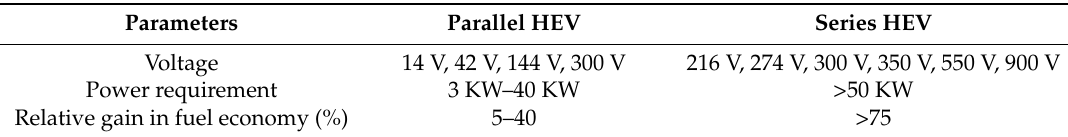
Table 4. Comparison of parallel and series hybrid configurations. Data from [8].